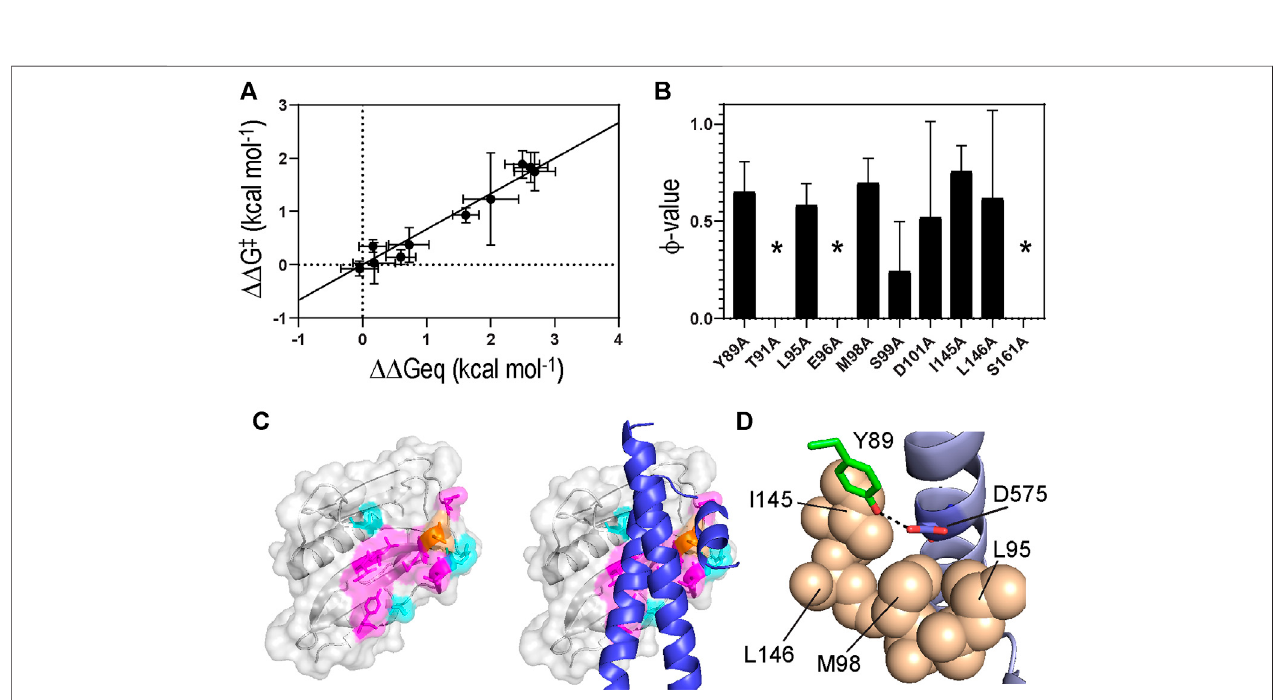
FIGURE 5 | (A) A linear free energy plot showing ΔΔ G ° against ΔΔ G ǂ (B) ϕ -values obtained for 1918 NS1 binding to p85 β . Asterisks correspond to the residues whose ϕ -values were not determined due to small ΔΔ G ° (C) (Left) Color-coded ϕ -values on the surface of 1918 NS1. Residues shown in magenta and orange have high-intermediate (0.5 – 0.8) and low ( < 0.5) ϕ -values, respectively. Residues showed small ΔΔ G ° ( < 0.5 kcal mol − 1 ) upon Ala substitution are shown in cyan (Right) Structureofp85 β issuperimposedonthe1918NS1structure (D) ThehydrogenbondbetweenY89ofNS1andD575ofp85 β .Hydrophobicresiduessurrounding the hydrogen bond are shown in sphere representation.